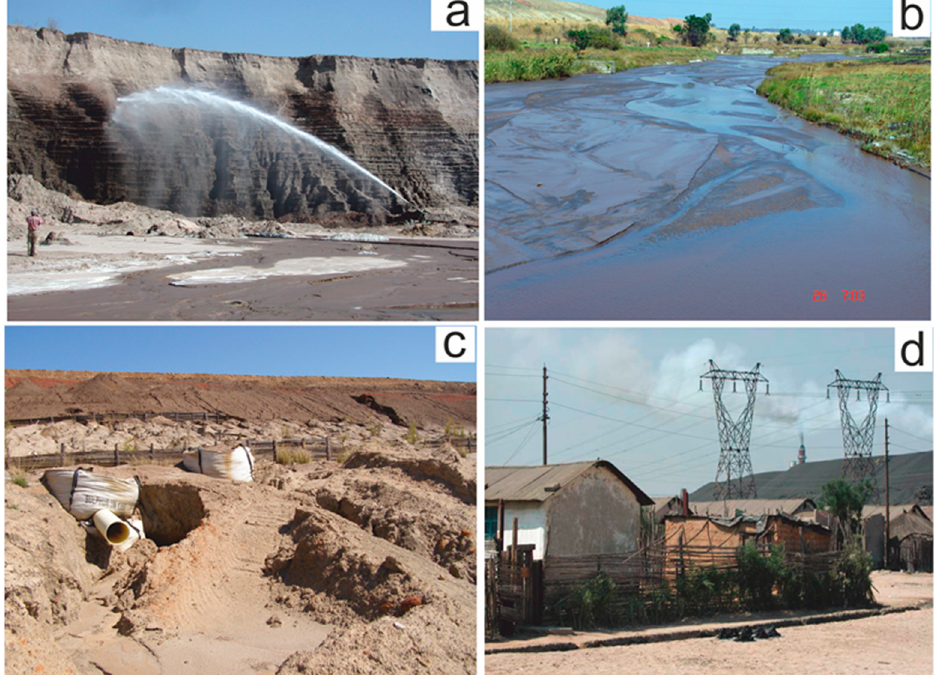
Figure 3. Main sources of contamination in the Zambian Copperbelt. ( a ) A part of old flotation tailings are eroded using hydraulic washing and they are processed in a chemical leaching plant in the Chingola Township. ( b ) An excess of tailings after hydraulic washing deposited in the Chingola River due to the insufficient capacity and low maintenance of the local Control Dam in Chingola. ( c ) The Bwana Mkubwa Chemical wastes dam. The dam is strongly deformed by erosion and seepage of technological waters. Light gray material at the foot of the tailings pond is used for dam stabilization. ( d ) Effects of sulfur dioxide emissions on buildings in the Kankoyo Township, part of Mufulira Town are documented by a rapid corrosion of steel roofs and discoloration of wall painting. Gardening in the backyards of houses in the immediate vicinity of the Mufulira Smelter is not possible due to high SO 2 loads. The author of the photos: Bohdan K ř íbek.